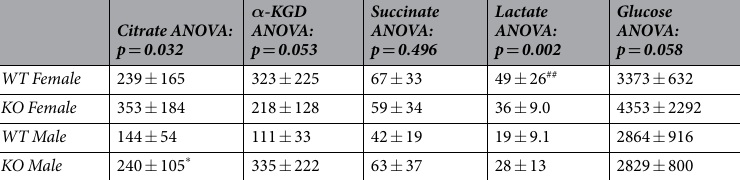
Table 2. Comparison of metabolite as measured in the urine from female and male Ppif − / − (KO) and wild- type (WT) mice. Data is presented as average ± SD (n = 7–12 in µ M per mM creatinine). One-way ANOVA significances are presented below. Tukey post hoc significance levels are as follows: * p < 0.05 for WT versus Ppif − / − animals (male and female), and ## p < 0.01 for male versus female ( Ppif − / − and WT, respectively). Abbreviations: α -KGD: α